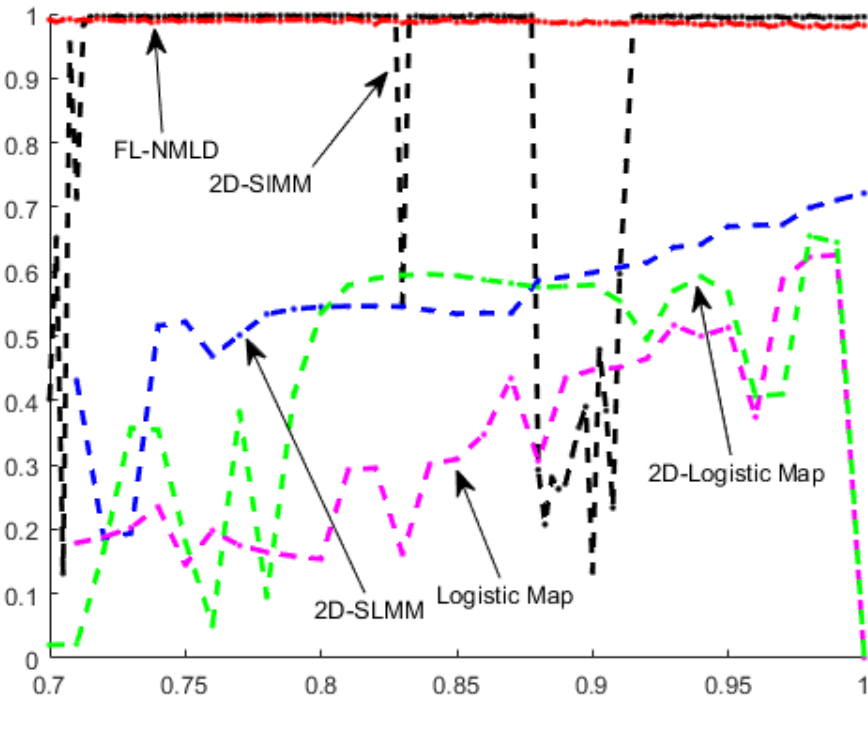
Figure 4. PE α /4 ( α 1 /4, α , r − 0.2, µ